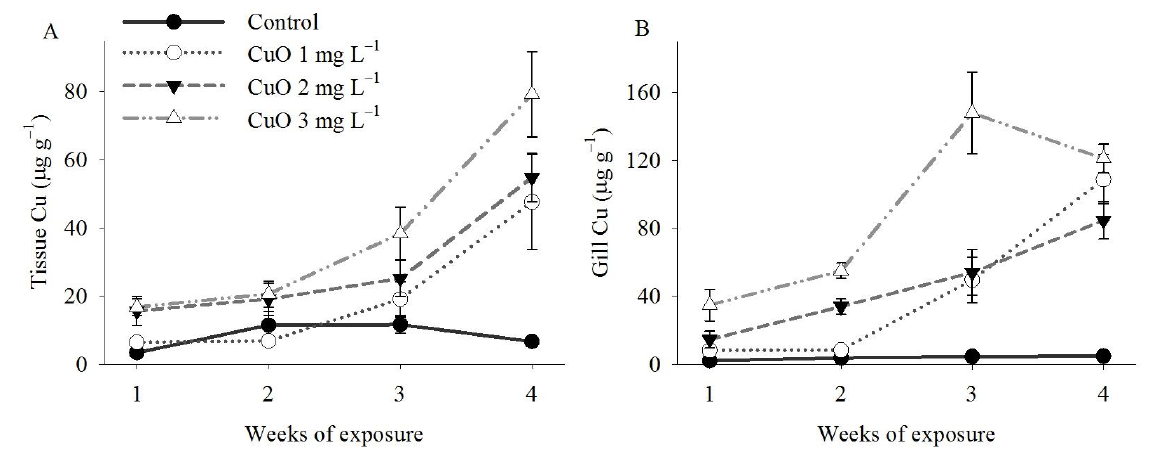
Figure 3. Bioaccumulation of Cu in mussels exposed to CuO ENPs. Mean Cu concentration in ( A ) tissue and ( B ) gill of mussels exposed to CuO ENPs for four weeks. The impact of CuO ENPs on Cu concentration in tissue and gill depended on exposure time (OLS: Tissue Cu = 0.78 − 4.31 (Concentration) + 3.26 (Time) + 5.72 (Concentration × Time), r 2 = 0.72; OLS: Gill Cu = −17.01 + 3.17 (Concentration) + 9.61 (Time) + 9.15 (Concentration × Time), r 2 = 0.74). Error bars are standard error of the mean.